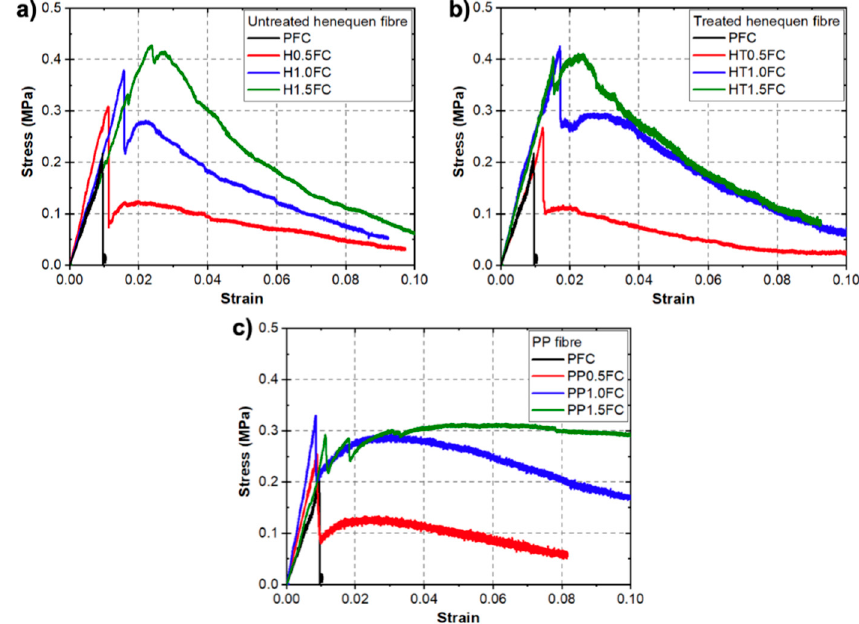
Figure 5. Typical uniaxial tensile stress–strain curves for reinforced foamed concrete mixtures with different fiber-reinforcements and volume fractions. A stress–strain curve of the PFC is included in each figure for comparison purposes: ( a ) untreated henequen fiber; ( b ) treated henequen fiber and ( c ) PP fiber.